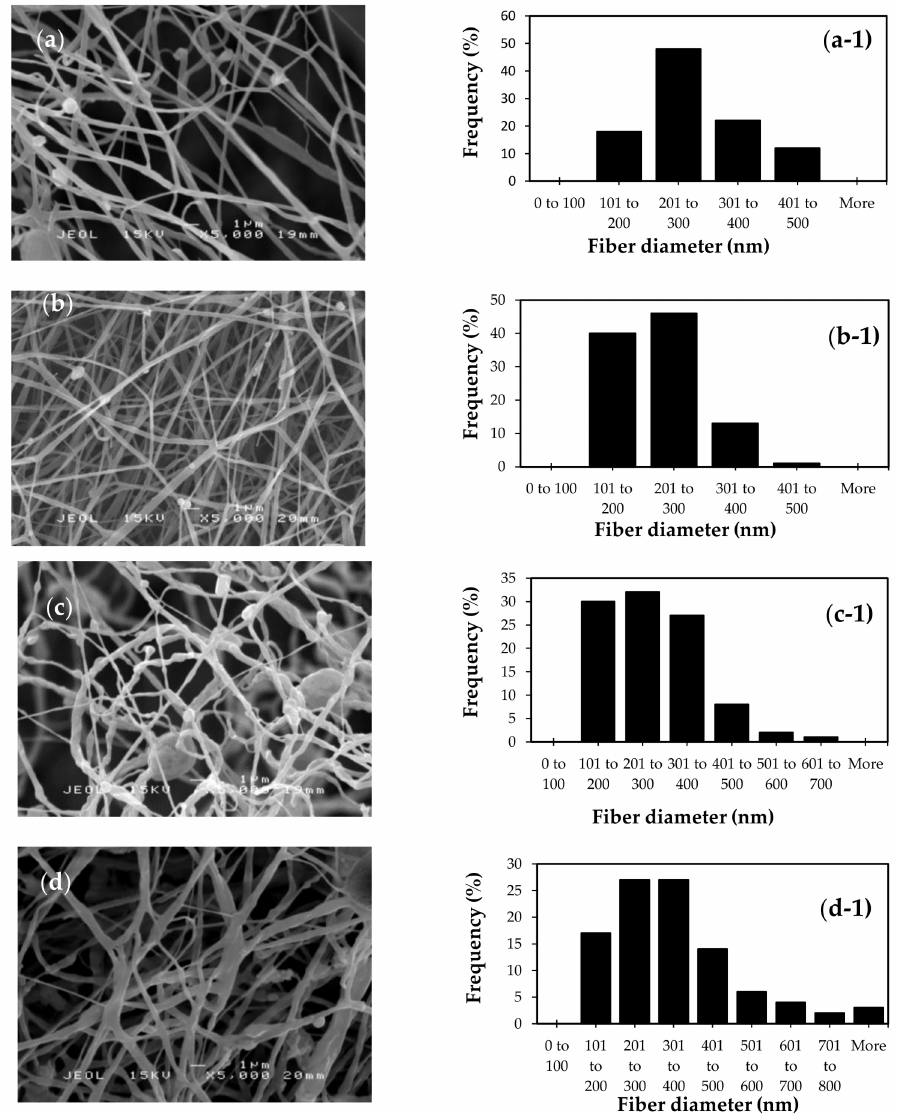
Figure 4. SEM images ( a – d ) and the corresponding fiber diameter distribution (( a-1 )–( d-1 )) of CMSP nanofibers produced at flow rate of ( a ) 0.6 mL / h, ( b ) 0.8 mL / h, ( c ) 1.0 mL / h and ( d ) 1.2 mL / h at fixed 10% concentration, 1:1 ratio, 20 kV of applied voltage and 15 cm tip-to-collector